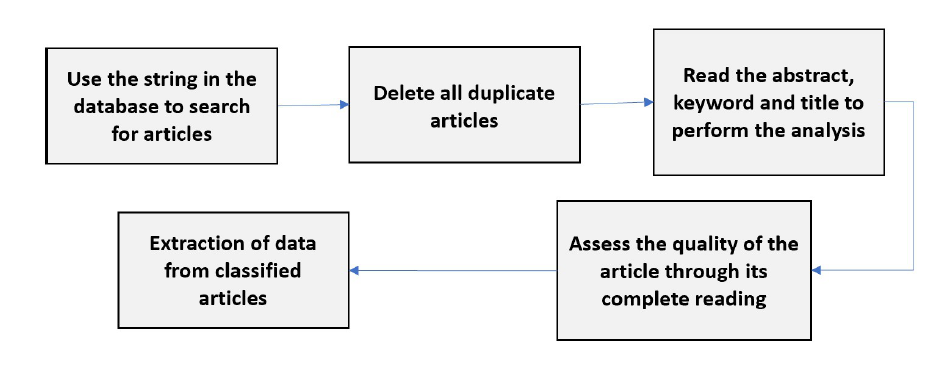
Figure 1. Conduction